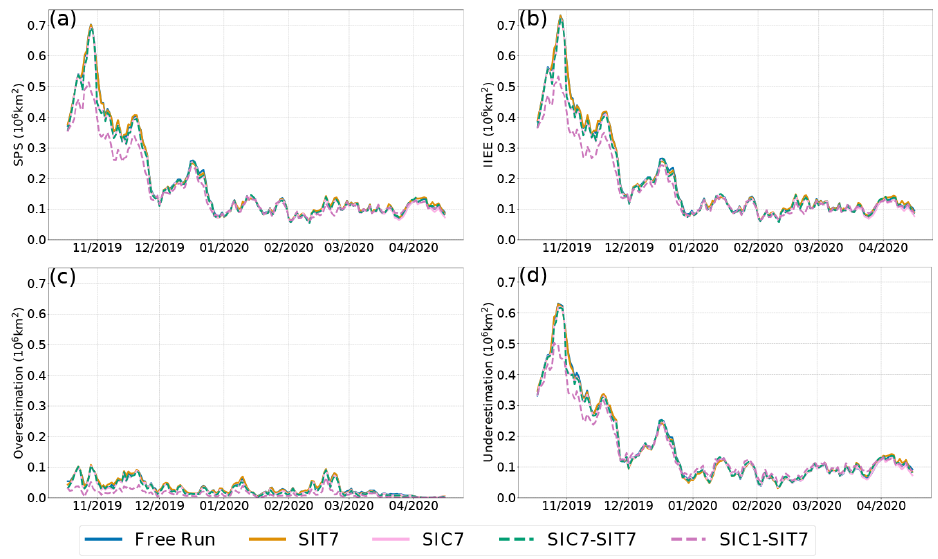
Figure 4. Metrics of sea ice extent validated against OSI-SAF SIC over time. (a) Spatial probability score (SPS) is calculated using the full ensemble forecasts. (b) Integrated ice-edge error (IIEE) is calculated using the ensemble means and split between its overestimation and underestimation components in panels (c, d) , respectively, which indicate the amounts of overestimation and underestimation in modeled SIE from the